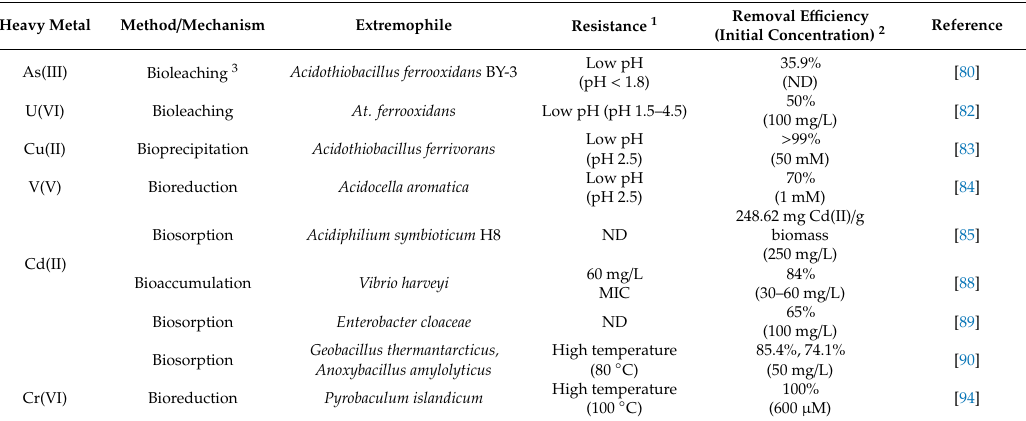
Table 1. Extremophilic microorganisms used in the removal of heavy metals.